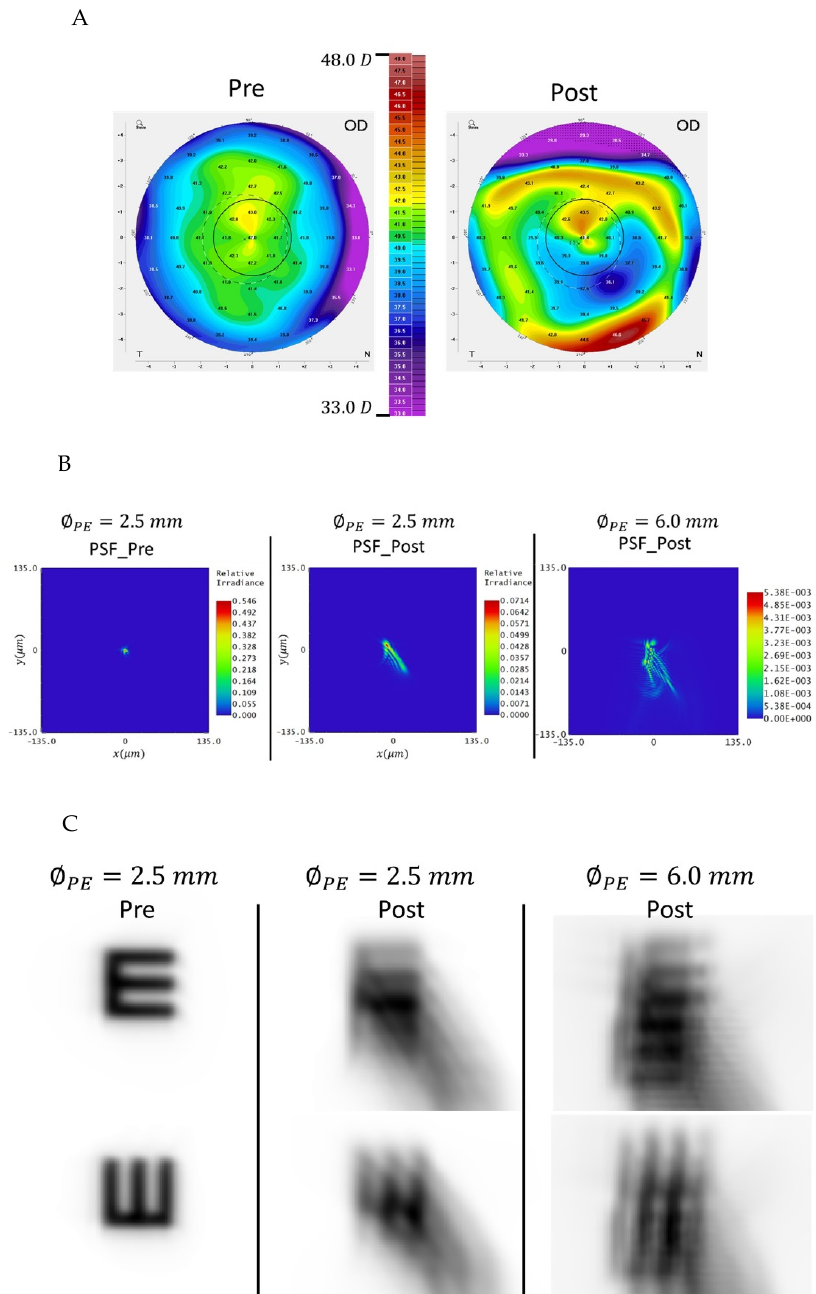
Figure 6. For Eye 3, ( A ) pre and postoperative topographies. Pupil size of 2.5 mm centred in apex is indicated with black circle; ( B ) pre and postoperative PSF functions for 2.5 mm and 6 mm pupil sizes; ( C ) pre- and postoperative vision simulated optotype for 2.5 mm and 6 mm pupil sizes.